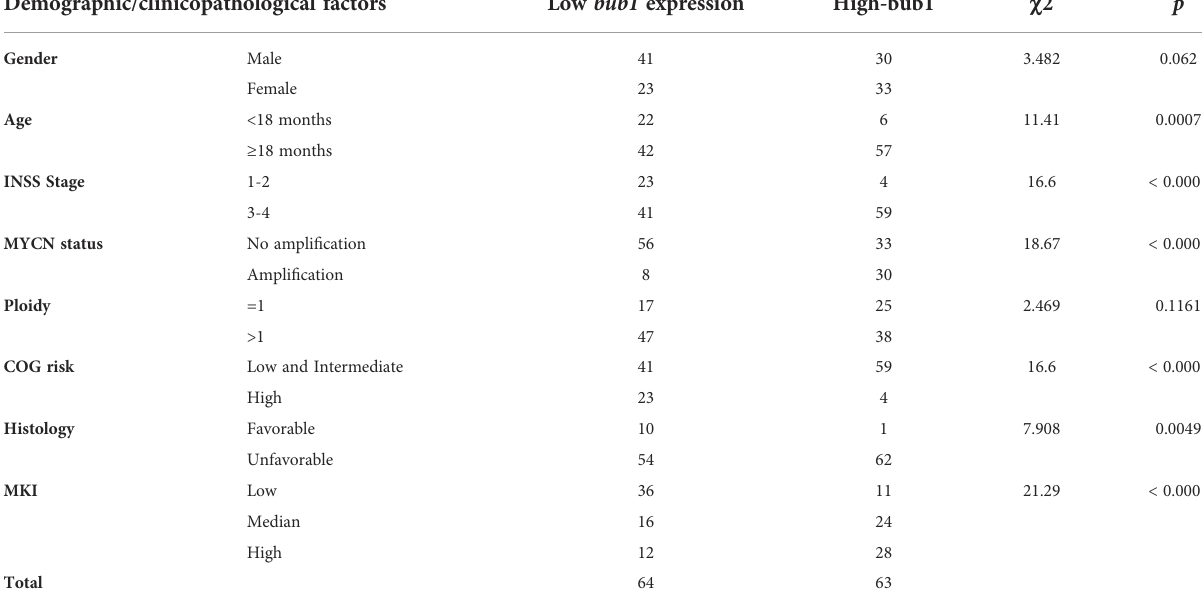
TABLE 2 Correlation between bub1 expression levels and demographic/clinicopathological factors of neuroblastoma.